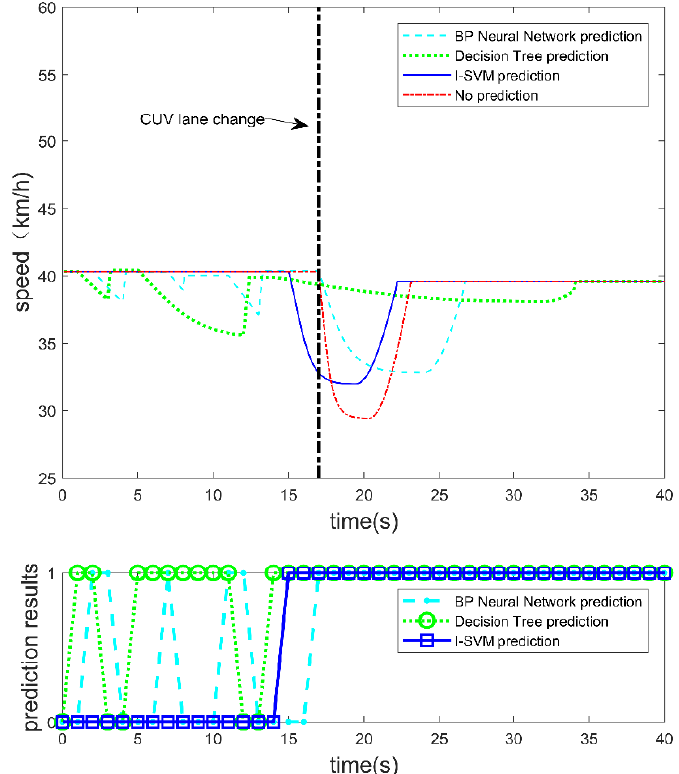
Figure 9. Speed of the autonomous vehicle with interference of CUV lane changing at 17th second.